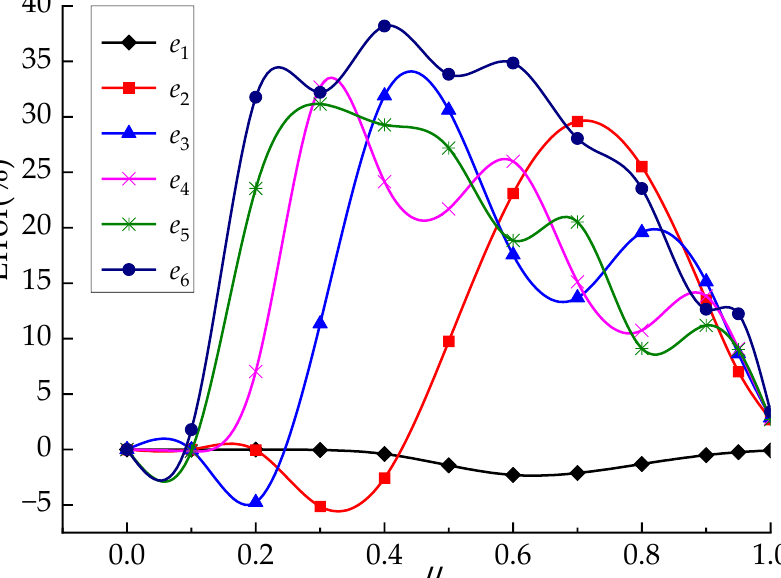
Figure 4. The percentage errors of the first six natural frequencies of the NAVMI factor solutions with respect to the Galerkin solutions for a partially submerged elliptical cylinder ( b 0 / a 0 = 0.5) with a cylinder–water density factor of γ = 5.0, as a function of the cylinder–water size factor µ.